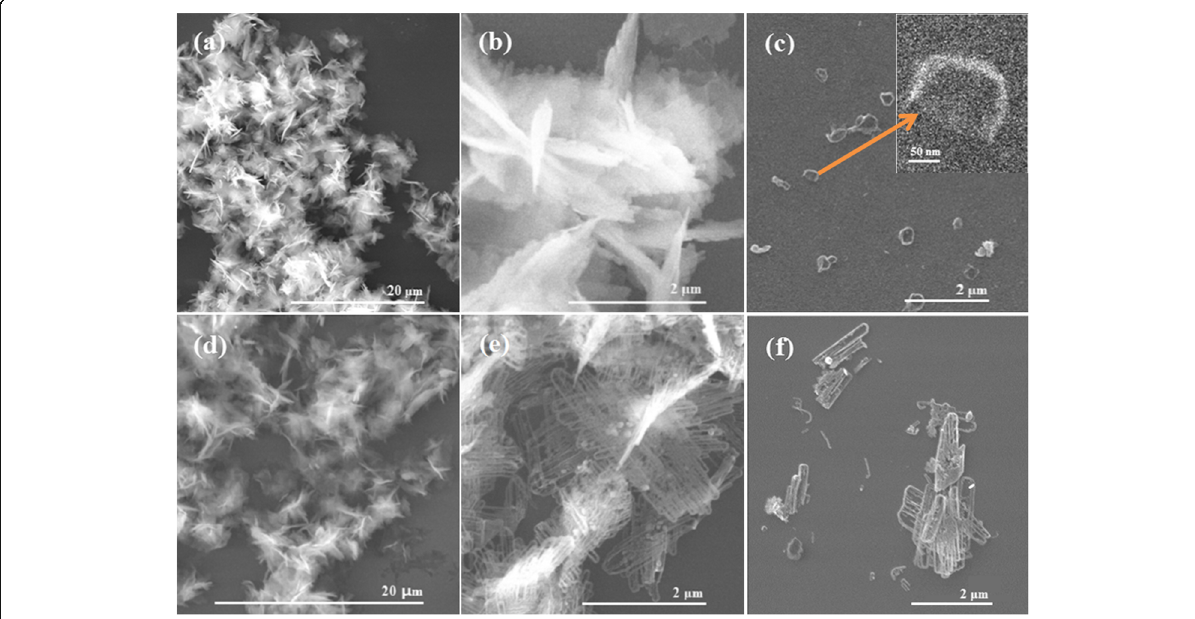
Fig. 4 SEM images of ZnO samples from 0.01 M Zn(OAc)2·nH 2 O solution at 170 °C with reaction times of ( a – c ) 12 min and ( d – f ) 2.5 h. The inset of ( c ) is the local magnification of a nano-ring